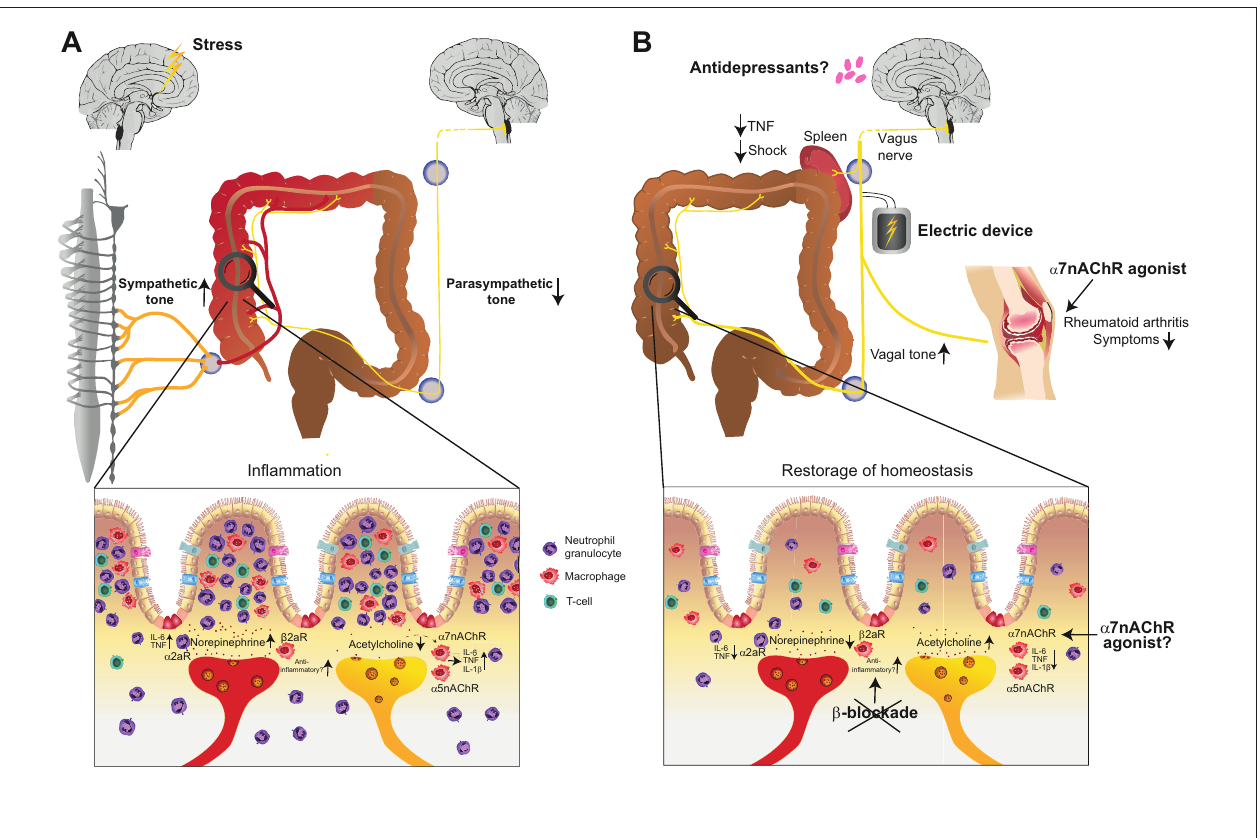
FIGURE 4 | Involvement of the autonomous nervous system in the pathogenesis of inflammatory bowel disease (IBD) and available treatment modalities that harness neuro-immune interactions. (A) Stress and the transmitted signals may enhance the sympathetic tone and lead to an additional pro-inflammatory reaction in the intestine that may be causal or at least worsening the course of IBD. Failure to maintain an adequate parasympathetic tone can further support the pro-inflammatory reaction. (B) Available treatment options in chronic inflammatory conditions include electric stimulation of the vagal nerve in rheumatoid arthritis, IBD and endotoxin-induced septic shock. Furthermore, the repertoire of treatment strategies for IBD and rheumatoid arthritis may be extended with α 7nAChR-agonists. β -blockade should, however, be omitted in IBD. α 7nAChR, alpha7 nicotinic acetylcholine receptor; α 5nAChR, alpha5 nicotinic acetylcholine receptor; α 2aR, alpha2 receptor; β 2aR, beta-2 adrenergic receptor; TNF, tumor necrosis factor